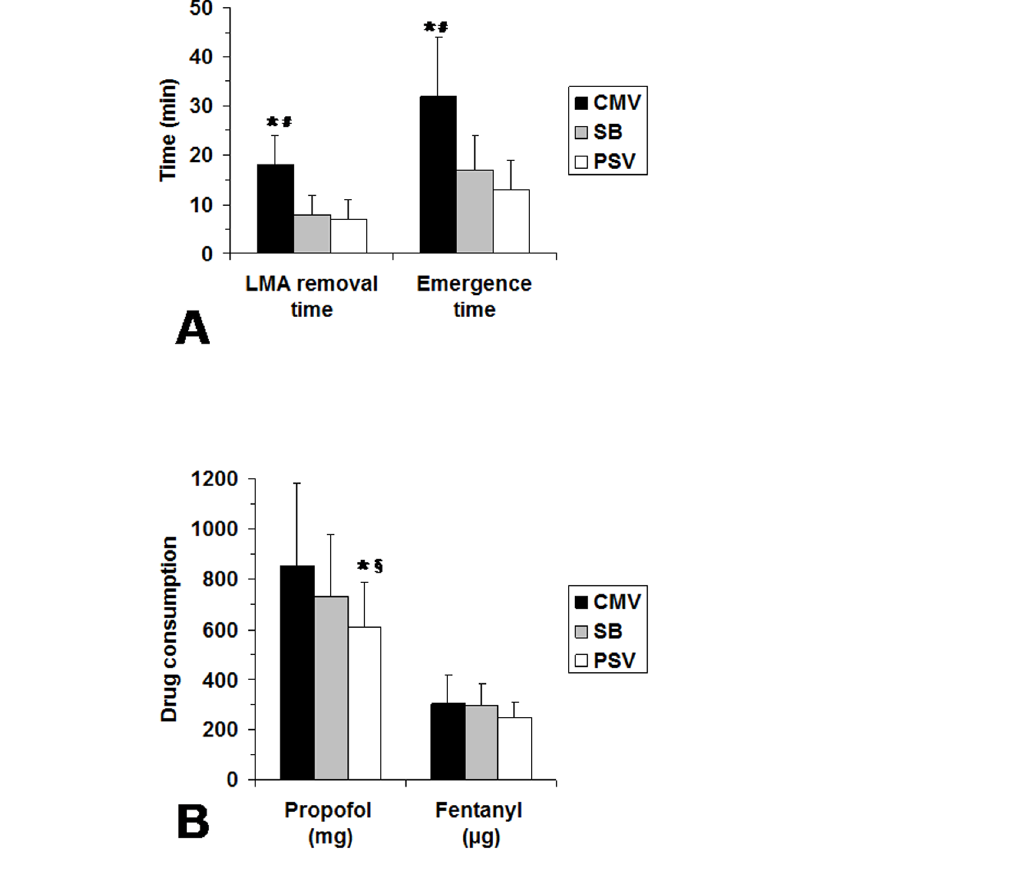
Fig. 3. Laryngeal mask airway removal, emergence times and total anaesthesia drug consumptions between the three groups. ( A ) Comparisons of the laryngeal mask airway removal and emergence times between the three groups: CMV: controlled mechanical ventilation; SB: spontaneous breathing and PSV: Pressure Support Ventilation. ( B ) Comparisons of the total anaesthesia drug consumptions between the three groups (CMV, SB and PSV). Results are expressed as mean ¡ SD (n 5 12 in each group). * P , 0.05 CMV vs PSV; # P , 0.05 CMV vs SB; 1 P , 0.05 SB vs PSV.